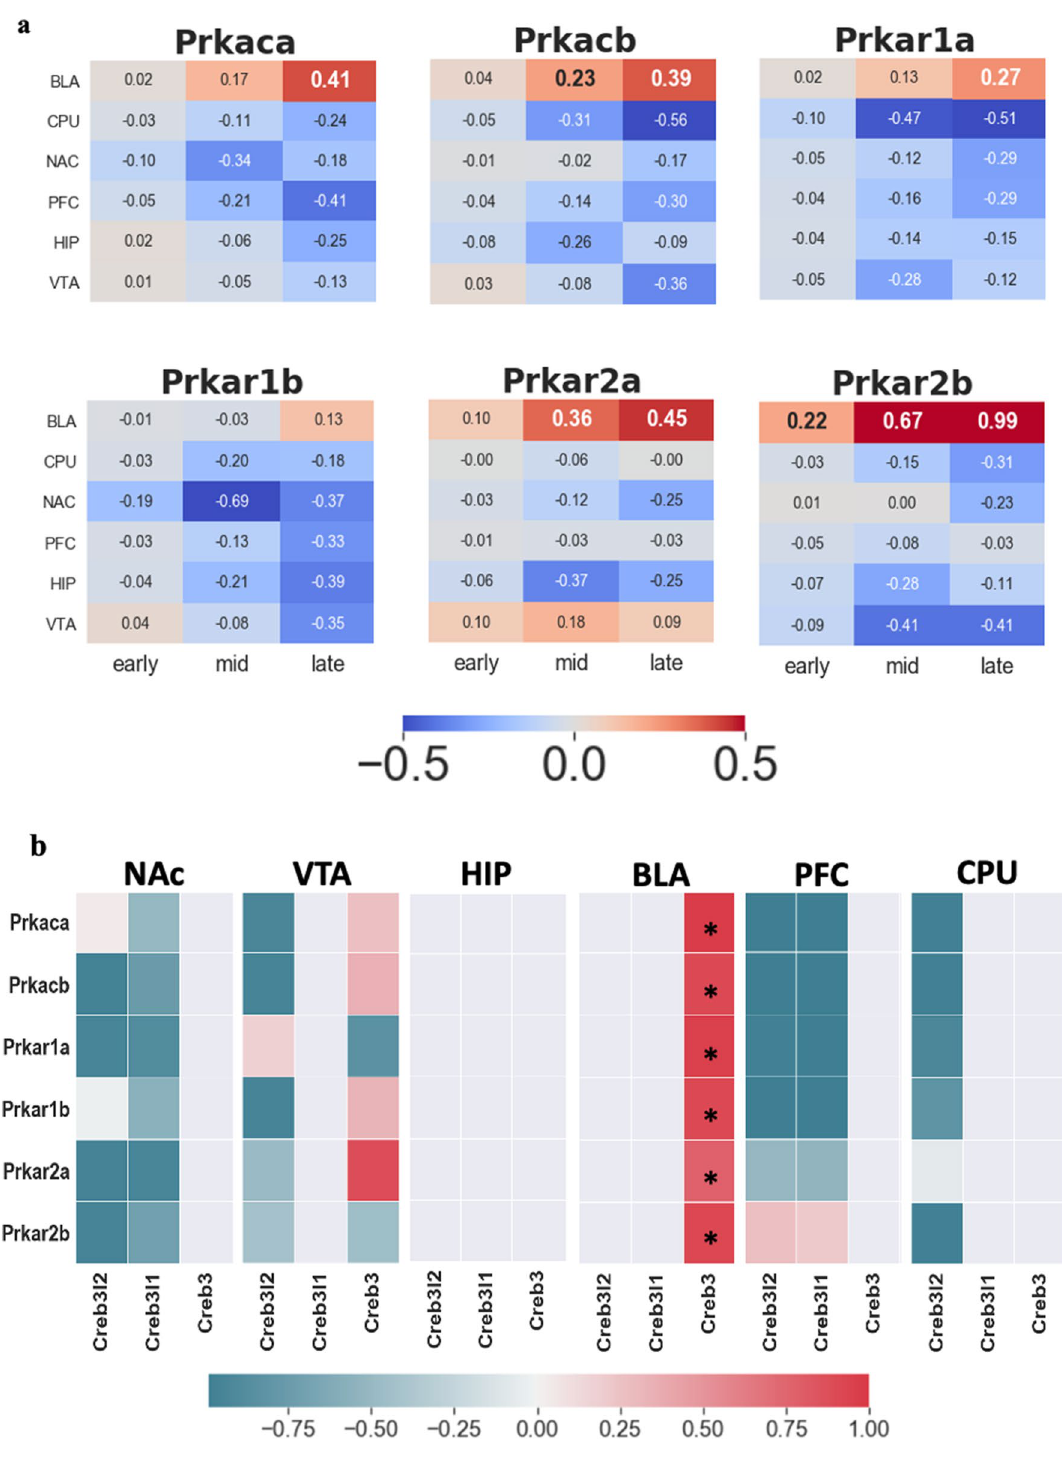
Figure 7. Relationship between Pka family and OASIS family. ( a ) Log2FC trend for Pka family in six brain regions. ( b ) Coregulation between Pka and OASIS family. Colored rectangles indicate only upregulation gene. Asterisk *indicates differentially expressed genes (Log2FC > 0.2) on both rows and columns. Reddish color indicates positive correlation between the genes. Teal color indicates negative